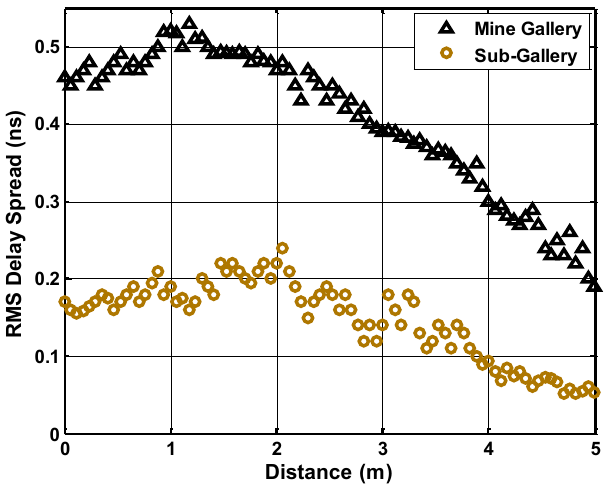
Figure 12. Comparison analysis of root mean square (RMS) delay spread (DS) response between the mine gallery and sub-gallery of the coal mine